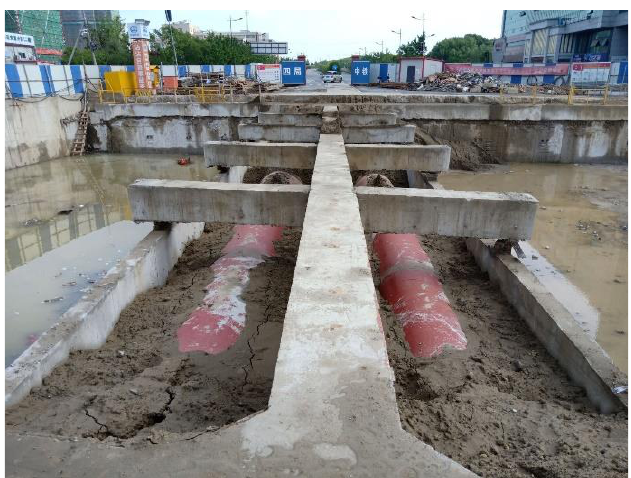
Figure 2. A photograph of the pipelines in the YRNE Project.